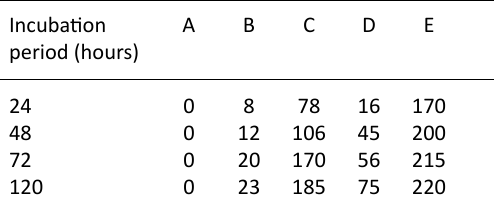
Table 3. The level of phosphatase enzyme activity (U/L) Incubation A B